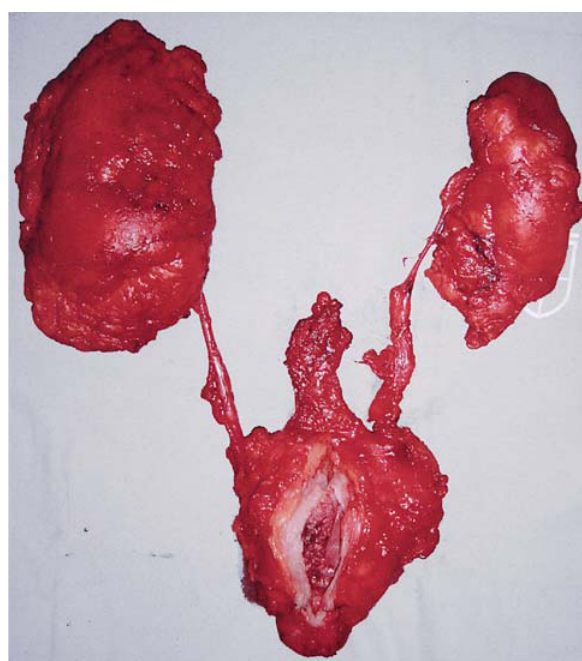
moval of the entire urinary tract and prostate, associated to ex- tended pelvic